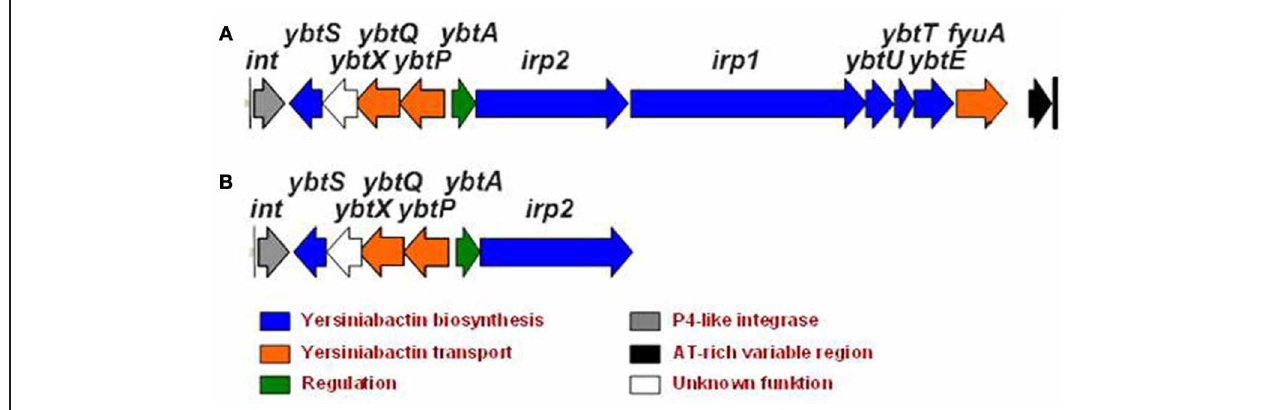
FIGURE 1 | Yersiniabactin gene cluster in Y. pseudotuberculosis O1 (A) and its truncated form in Y. pseudotuberculosis O3 (B).